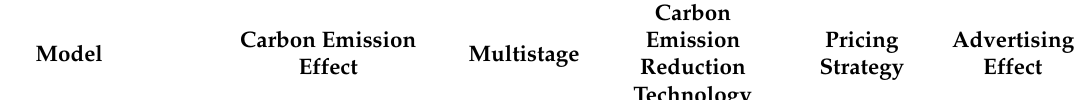
Table 1. Comparison of the main characteristics of this study and previous